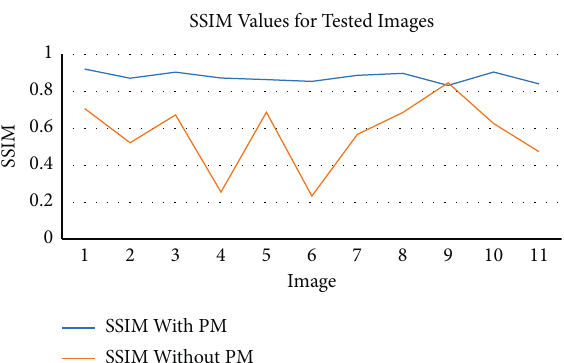
Figure 11: SSIM value for tested images.